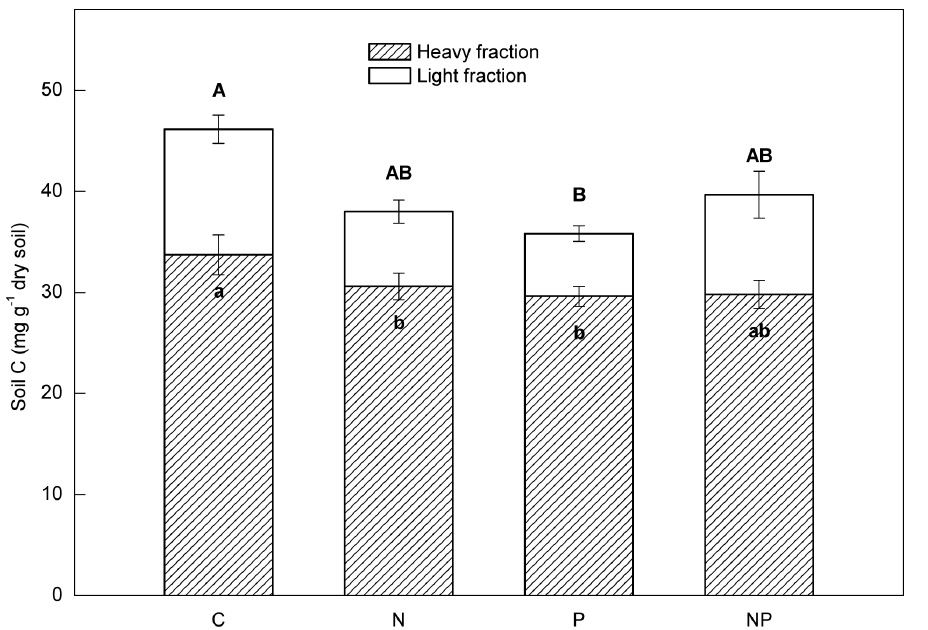
Figure 1. The contribution of two soil fractions to total soil C (Jun. 2011). C: control, N: nitrogen addition, P: phosphorus addition, NP: nitrogen and phosphorus addition. Significant differences (p , 0.05) among treatments are indicated by different letters. Error bars show SE (n=5).